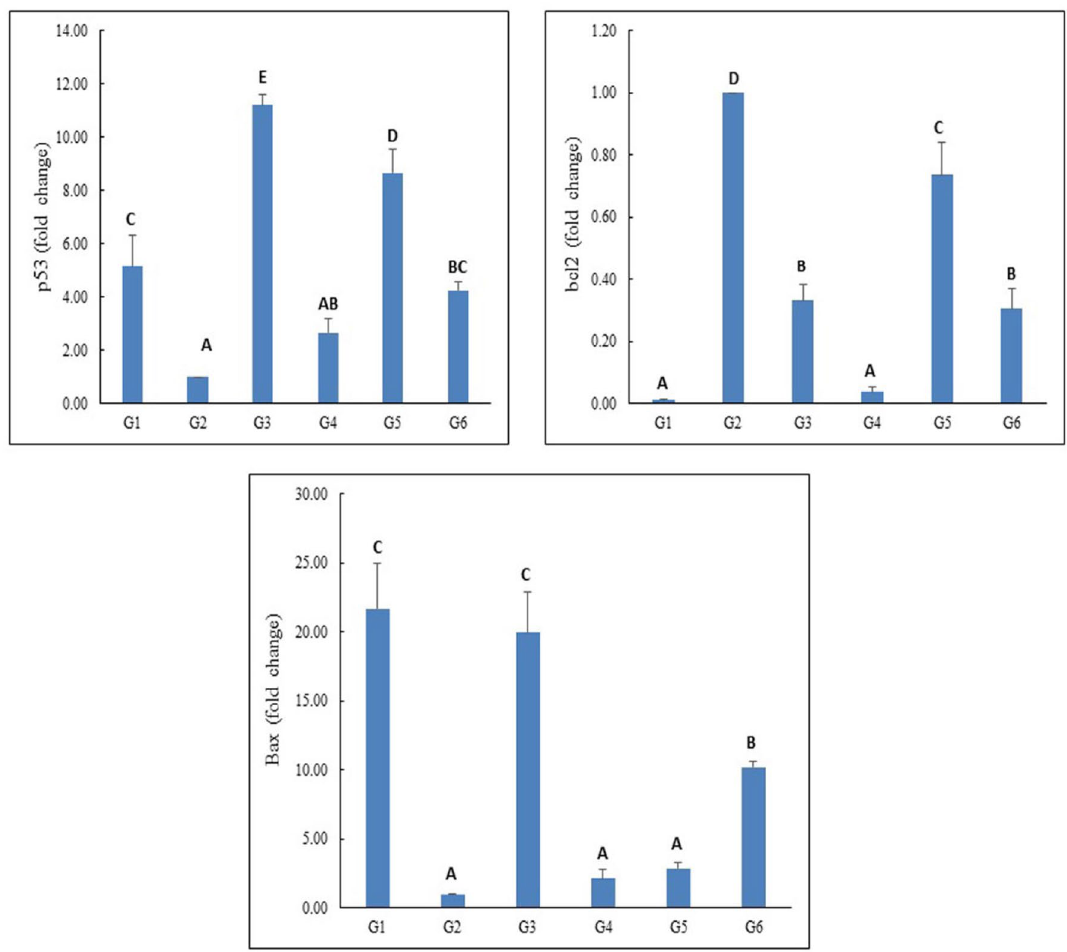
Figure 8. The expression levels of P53, Bcl2 and Bax genes in the tumor control group (G2), doxorubicin- treated group (G3) and groups treated with 100, 200 or 400 mg/kg of PSO nano-emulsion (G4, G5, G6) respectively. Data is displayed as mean ± standard error. Means marked with the same superscript small letters are insignificantly different ( p > 0.05), whereas those marked with different ones are significantly different ( p < 0.05).